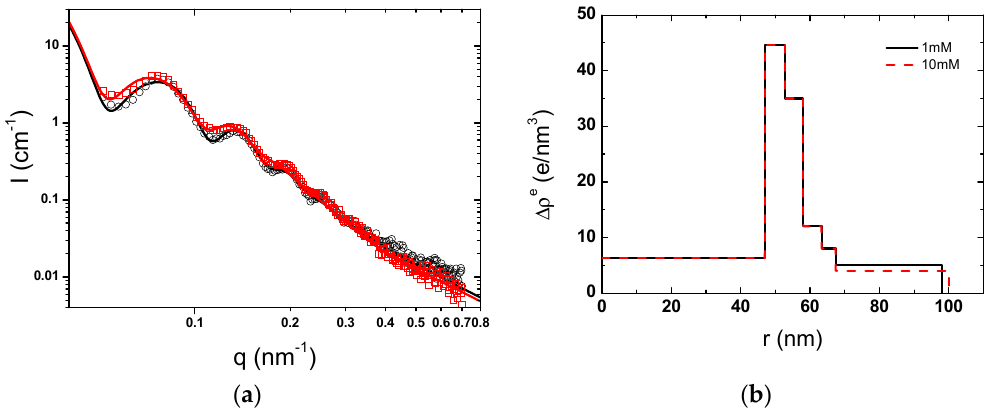
Figure 11. ( a ) Scattering intensity curves of PAA-PAH-PAsp triple-layer modified SPBs at NaCl concentrations of 1 mM ( ○ , black), and 10 mM ( □ , red). Solid lines represent the fitting curves; ( b ) Excess electron density of PAA-PAH-PAsp at different salt concentrations.